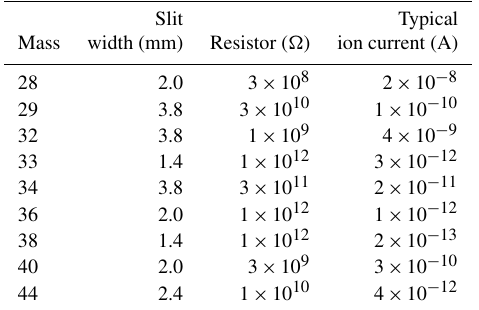
Table 3. Collector configurations of the mass